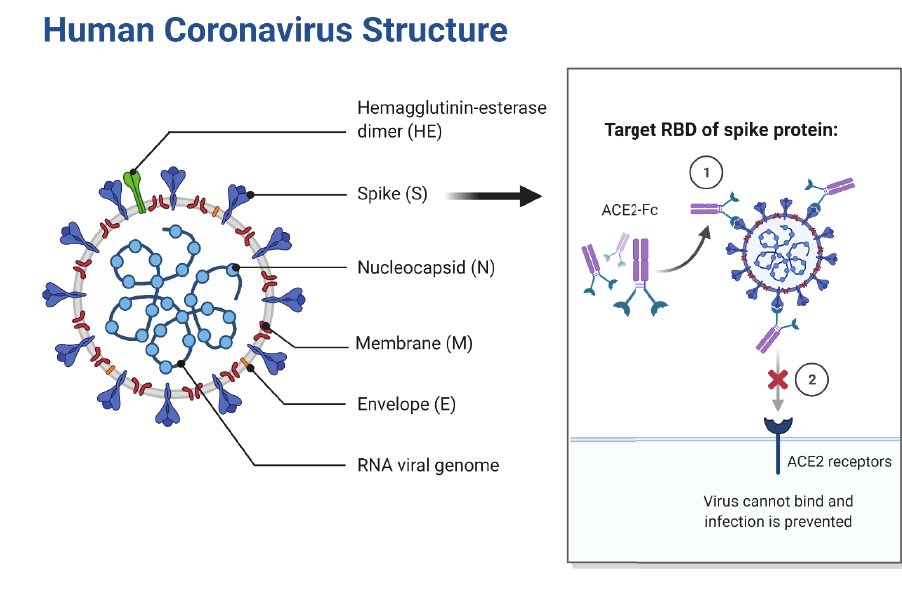
Figure 1 : Structure components of severe acute respiratory syndrome coronavirus 2 (SARS-CoV2). Spike proteins are the potential targets for therapeutic treatment of COVID-19 as they facilitate entry of virion into the host cells. The receptor-binding domain (RBD) in this virus is demonstrated to be strongly bound to angiotensin-converting enzyme 2 (ACE-2) receptors. Created with